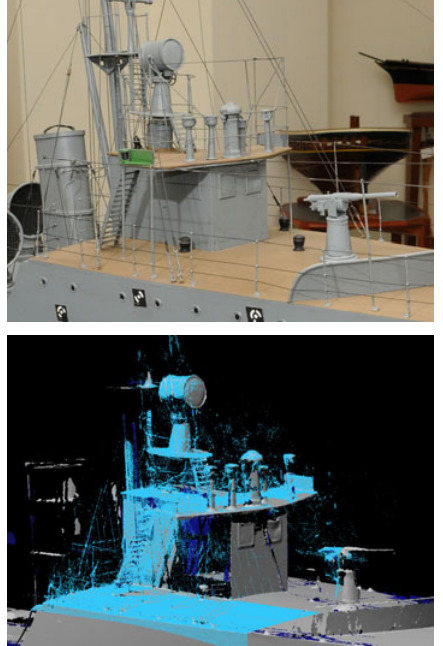
Figure 7: Noise and artefacts caused by shrouds.